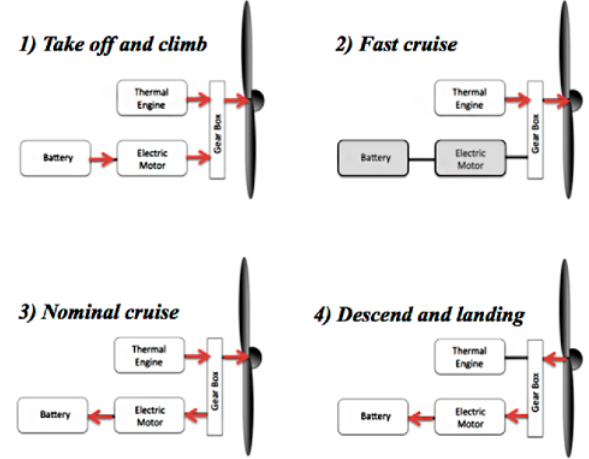
Fig. 7. Parallel hybrid exploitation in different